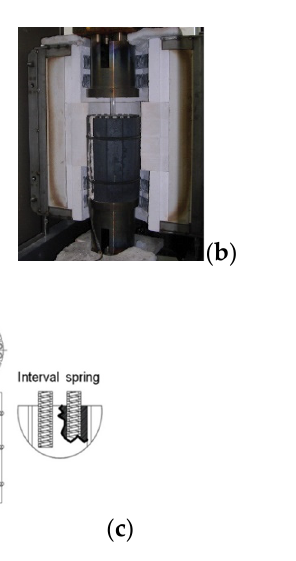
Figure 3. Heat transfer device; ( a ) heating flow; ( b ) transmission plate; ( c ) Transmission plate detail.